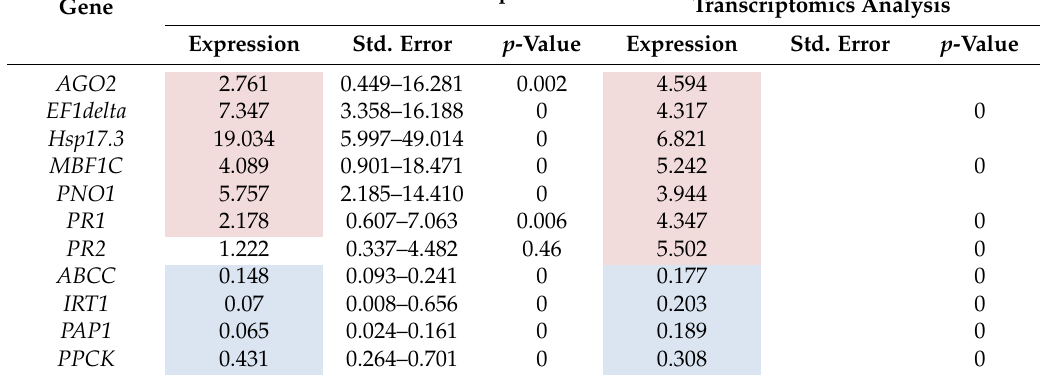
Table 5. Validation of the gene expression in PSV-G + satRNA treated plants by RT-qPCR compared to the results obtained from transcriptomics analysis (red-colored cells represent up-regulated genes, while, the blue-colored—down-regulated